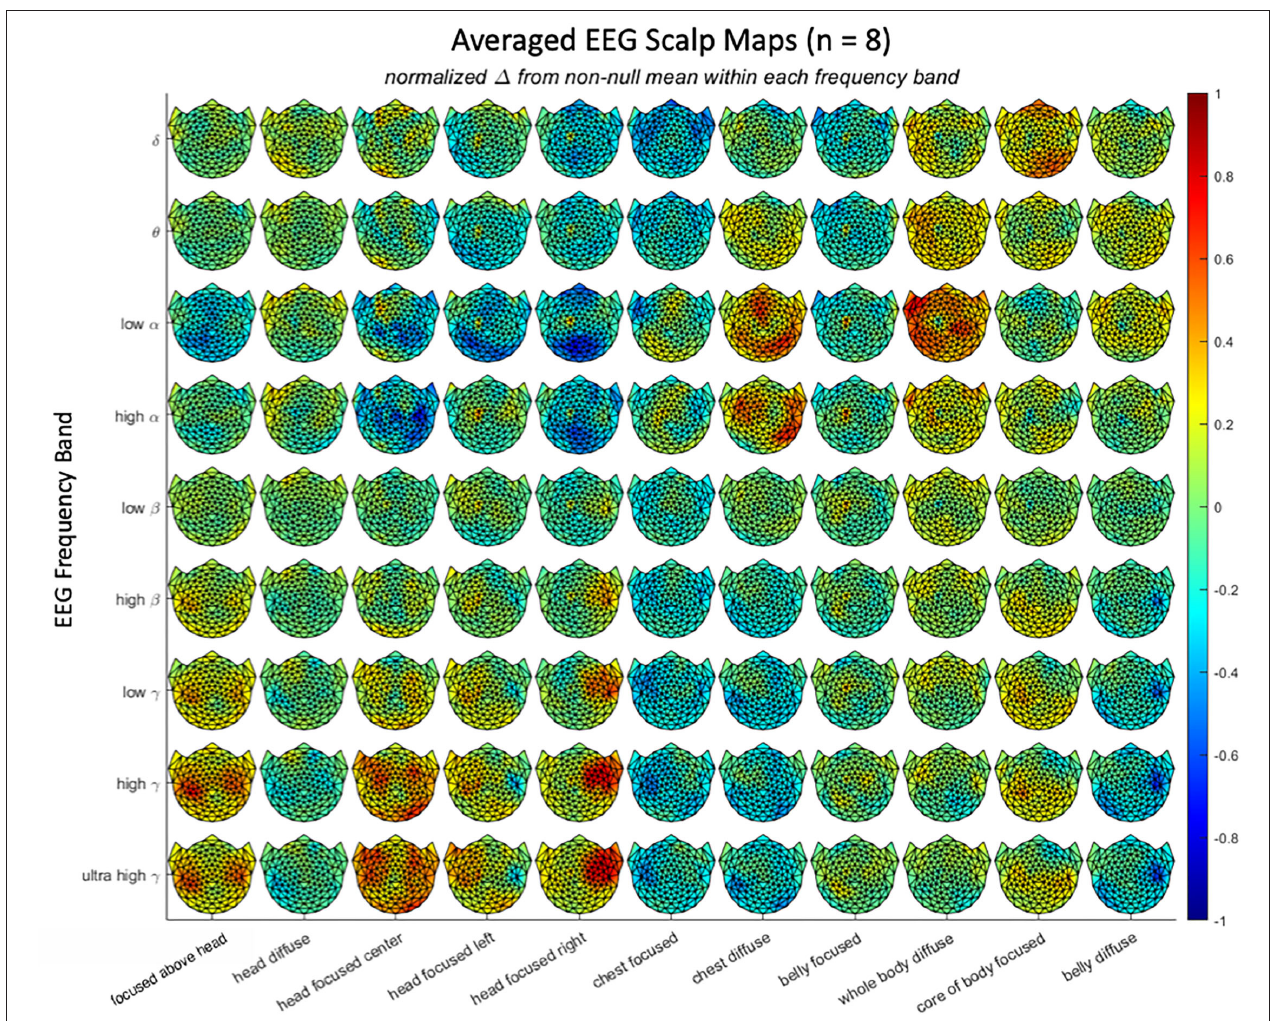
FIGURE 3 | Average scalp maps of activation in the 11 attentional states for each of 9 EEG frequency bands, relative to the null state of reading text. Color bar shows the coding for normalized EEG amplitude from negative to